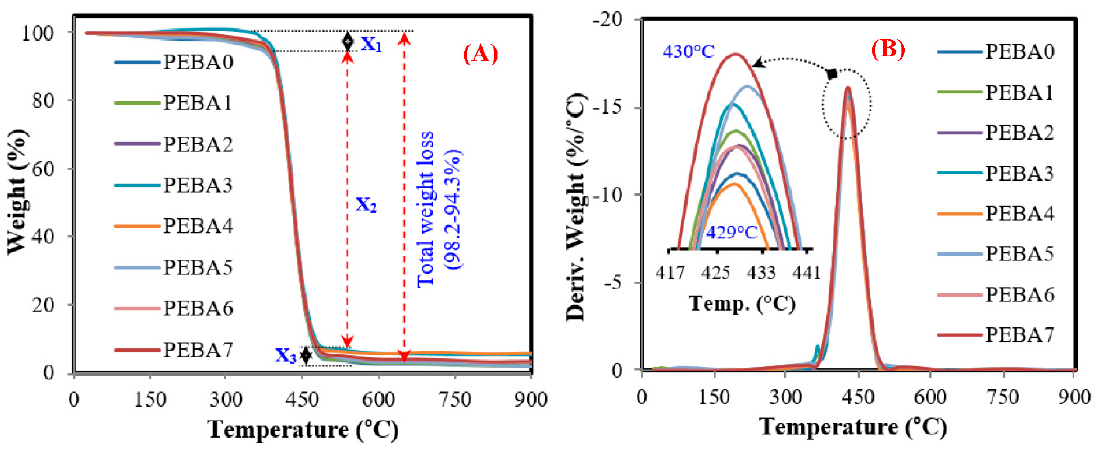
Figure 8. ( A , B ) typical TGA and DTG curve analysis of the synthesized membranes, respectively.